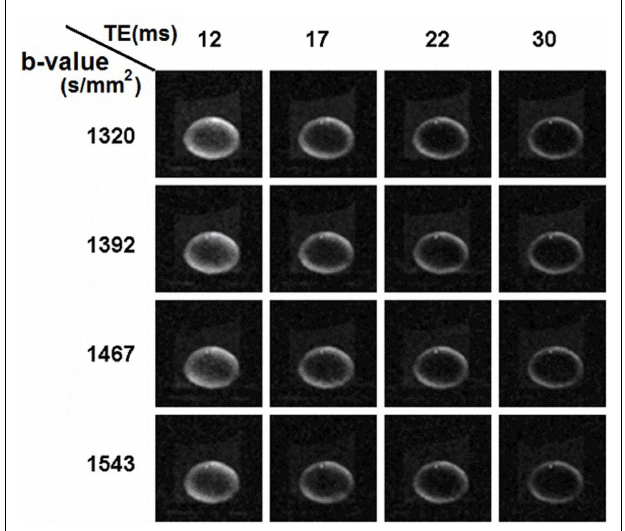
FIGURE 6 | Ocular lens imaged using diffusion weighting pulse sequences with combinations of different b -values andTEs. In the second set of diffusion-weighted experiments (see Materials and Methods), b -values within the range of 1300–1600s/mm 2 were tested with a range of T E from 12 to 30ms in unidirectional diffusion-weighted scans. For the combinations tested, there was a pronounced, general loss of signal as T E was increased; as well as attenuation as b -value was increased, consistent with the results shown earlier.The lens, image slice and diffusion gradients were oriented as in Figures 4 and 5